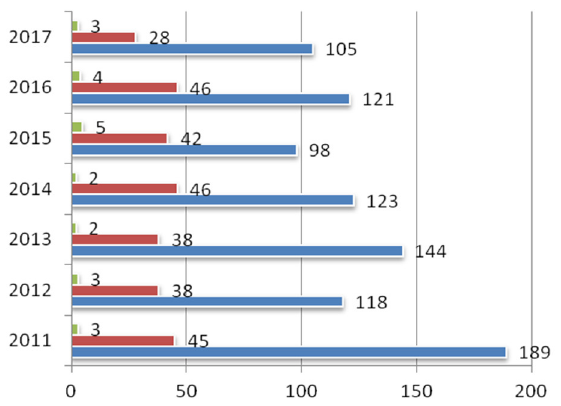
Figure 2. Types of TB in Aragon. Blue line: Respiratory TB. Red line: Other Tb. Green line: TB meningitis.